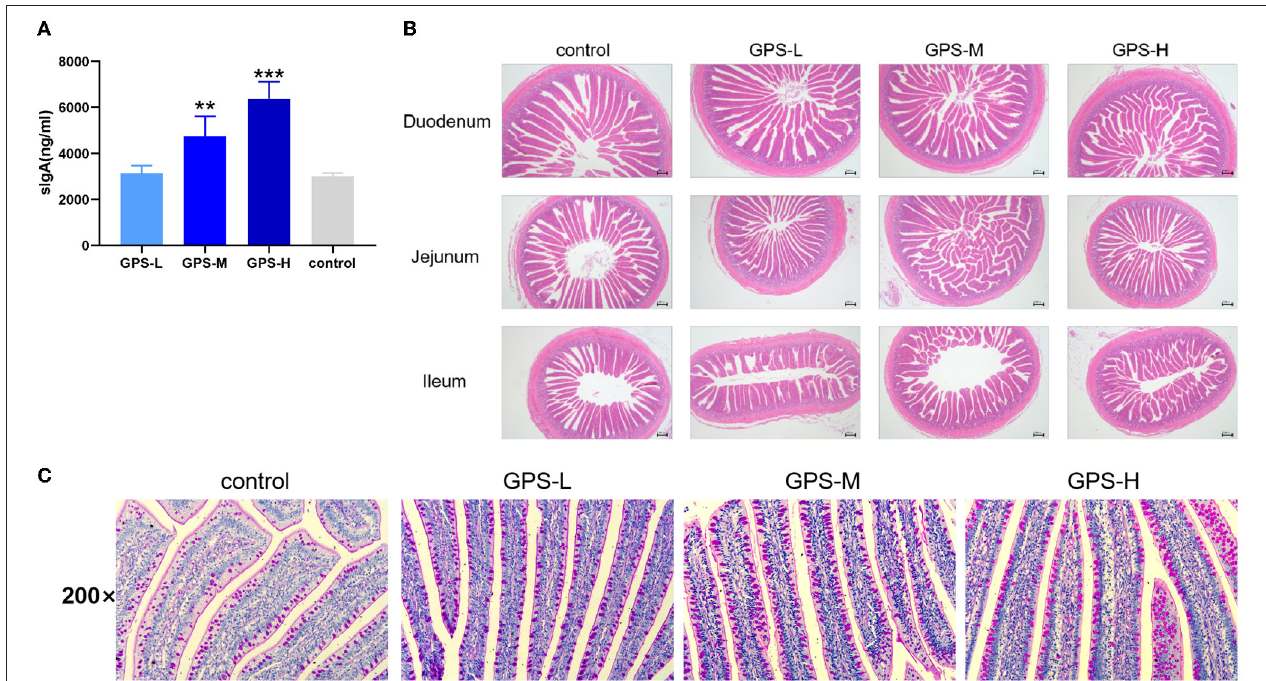
FIGURE 1 | (A) Effects of 14-day oral administration of GPS on intestinal secretion of sIgA in laying hens. (B) Hematoxylin-Eosin (HE) staining was used to observe the effect of GPS on the histology of the small intestine of laying hens after 14 days of oral administration. (C) Glycogen was labeled using PAS staining to show goblet cells (darker granules) in the gut, and the effect of 14-day GPS oral administration on the number of intestinal goblet cells in laying hens. * P < 0.05, ** P < 0.01, and *** P < 0.001, all relative to the saline (control)